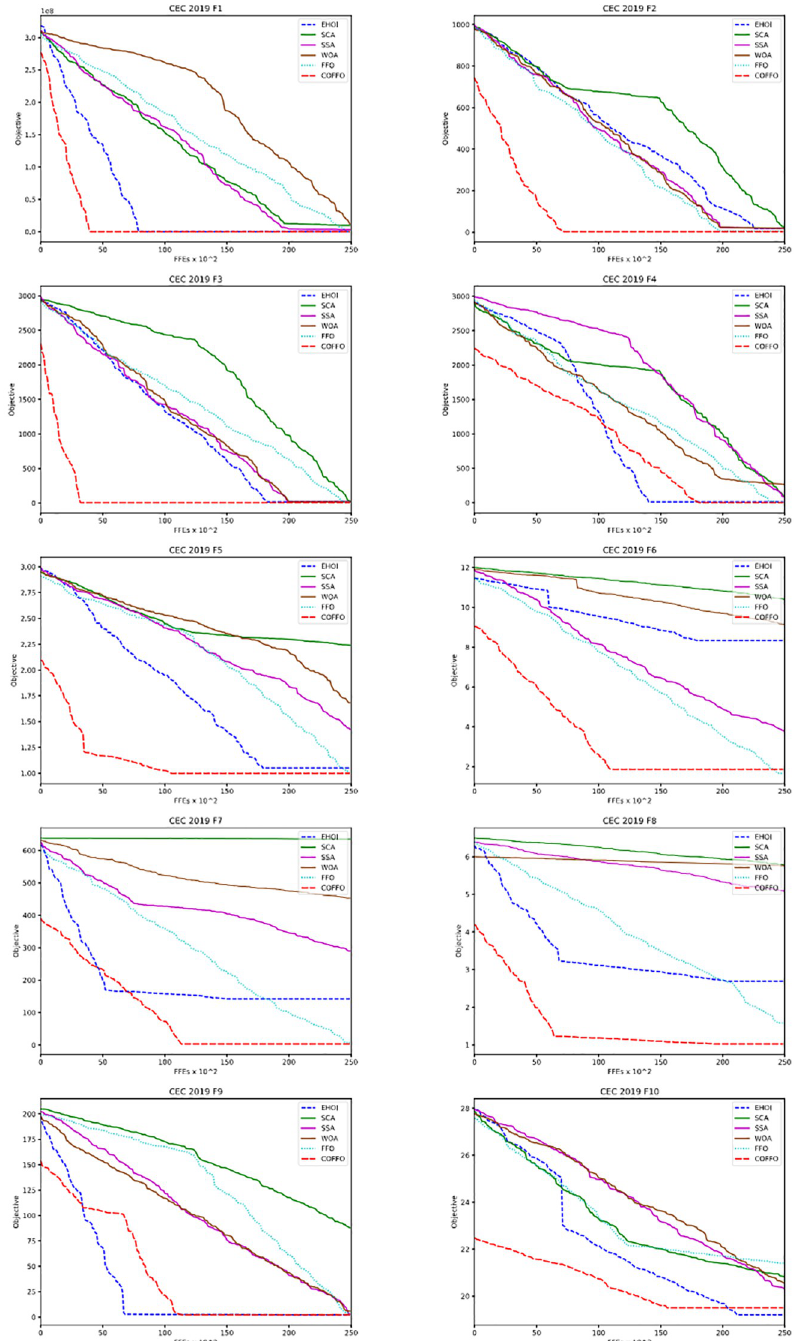
Fig 1. Convergence graphs for ten CEC 2019 benchmark functions and direct comparison between COFFO and